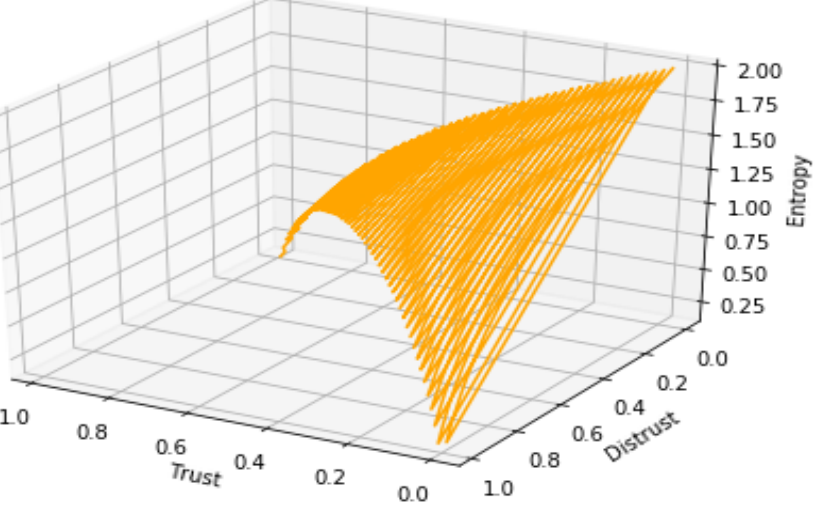
Figure 3. The entropy when frame of discernment is Ω = { T , nT } . As is shown, entropy is in the range of [ 0,2 ]